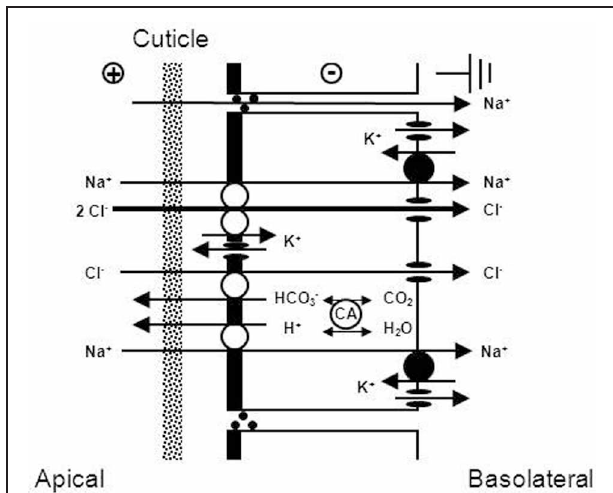
FIGURE 4 | Transport mechanism proposed for transbranchial NaCl uptake across the gills of hyperosmoregulators characterized by “leaky” gill epithelia and high transport rates (from Onken et al., 2003). Active NaCl uptake is coupled and proceeds via Na + /K + /2Cl − cotransporters in the apical membrane. Absorbed Na + ions are then pumped by the Na + /K + -ATPase across the basolateral membrane. The presence of basolateral and apical K + channels results in a negative electrical potential inside of the cells which drives the movement of Cl − ions through Cl − channels in the basolateral membrane. Apical K + channels are also of importance to supply the apical Na + /K + /2Cl − cotransporters with K + ions, and give the overall transport its electrogenic nature. The outside positive transbranchial voltage can then be used as the driving force for paracellular Na + absorption to ensure equimolar NaCl absorption. In addition, active NaCl uptake proceeds via cation (Na + /H + ) and anion (Cl − /HCO − 3 ) exchangers in the apical membrane, supported by a carbonic anhydrase that catalyzes the fast production of acid/base equivalents as intracellular substrates for the